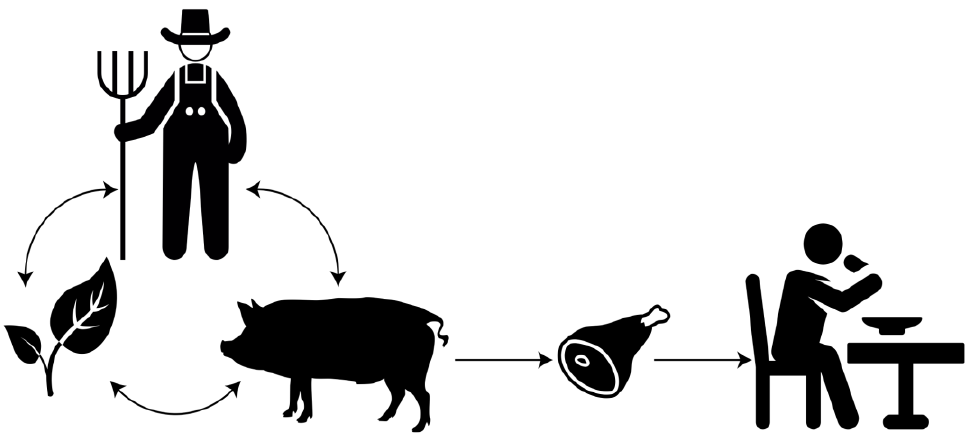
Figure 1. Representation of several interconnected components influencing the quality of pork meat.